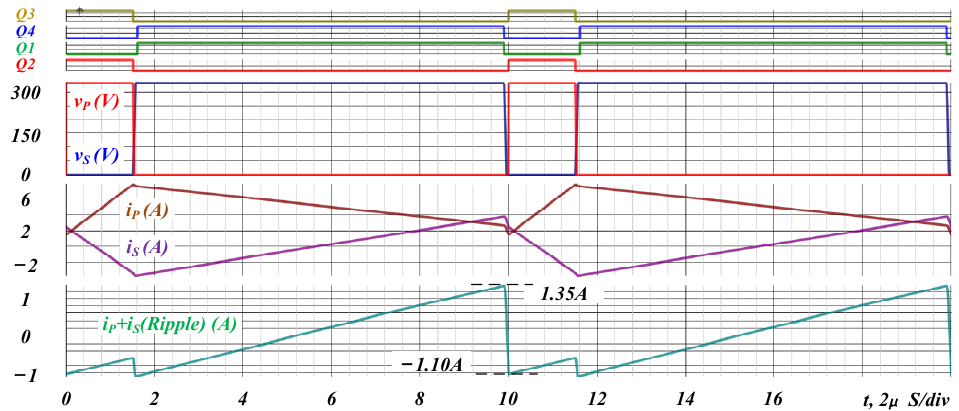
Energies 2021 , 14 , 64 FOR PEER REVIEW Figure 18. Simulation results of the output current ripple of a stacked buck converter with conventional dead time.